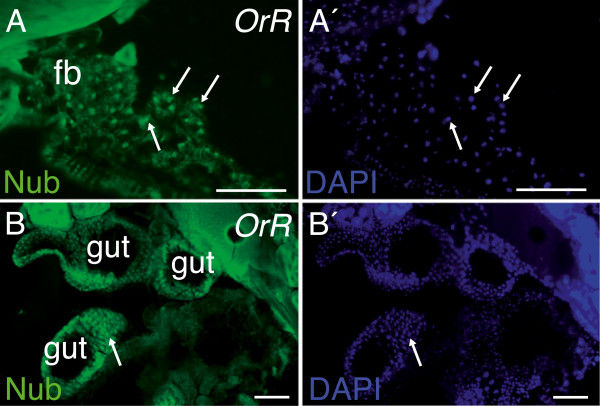
Localization of Nub protein in immunocompetent tissues of flies. (A,B) Immunostaining of Nub in frozen cryostat sections of uninfected OrR flies using a peptide-specific antibody directed against a common epitope of Nub-PB and Nub-PD protein. Nuclei stained with 4′-6-diamidino-2-phenylindole (DAPI) (A′-B′). Cryostat sections (20 μm thick) of adults showing nuclear (arrows) and cytoplasmic and staining of Nub in fat body tissue (A,A′) and in cross-sections of midgut (B,B′). Scale bars, 100 μm.